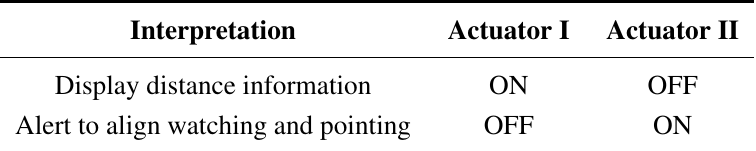
Table 5. A configuration of dual actuators with its interpretations.